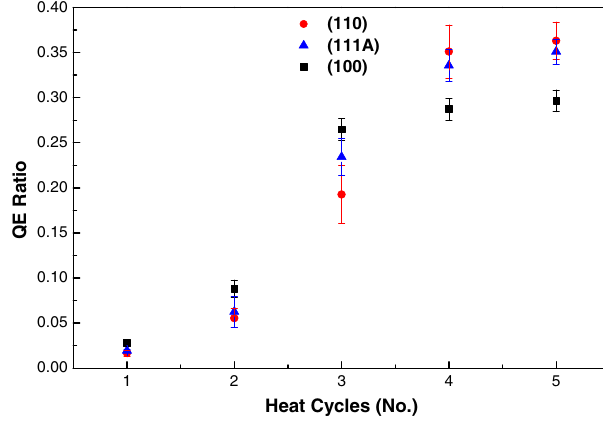
FIG. 9. QE ratio — samples implanted with 10 000 V hydrogen ions to samples that were not exposed to hydrogen ions — as a function of heat cycle, for bulk GaAs with three different surface cleave planes. Heat cycle numbers: 1: 250 ° C for 20 min; 2: